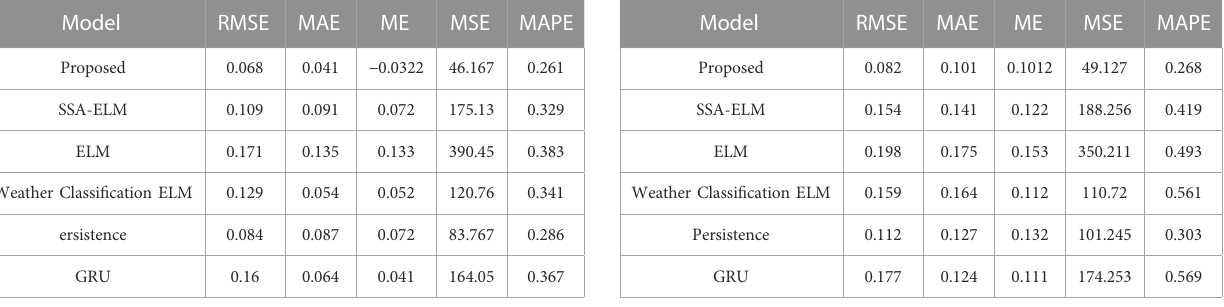
TABLE 2 Average value of each error index in Qinghai Province. Model